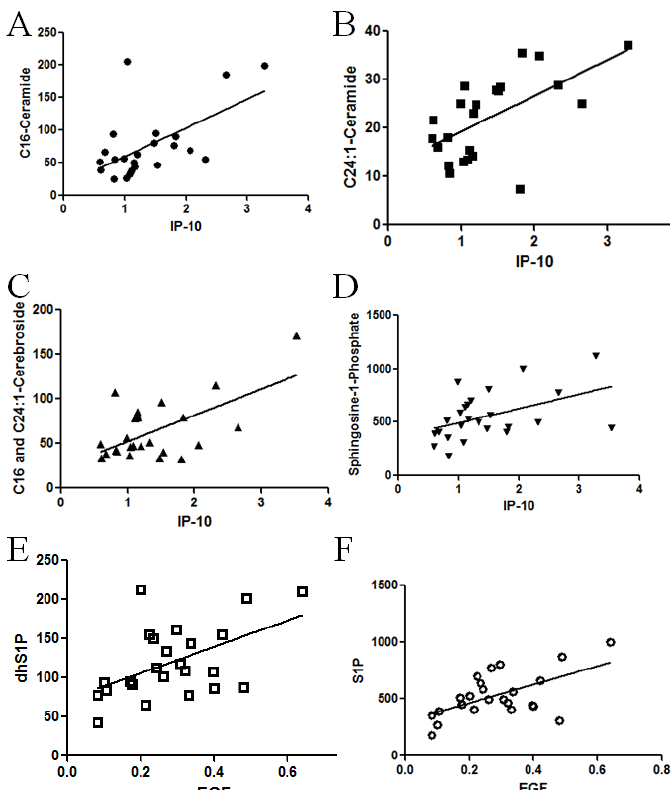
( A ) Tissue C16-ceramide and plasma IP-10 levels ( r = 0.583, p = 0.0035); and ( B ) tissue C24:1-ceramide and plasma IP-10 levels from tissue demonstrate a positive correlation ( r = 0.6012, p = 0.0024); ( C ) as did plasma C16:0 and C24:1 cerebroside mass ( r = 0.6174, p = 0.0013), with plasma IP10; and ( D ) plasma S1P with IP10 ( r = 0.4655, p = 0.019). Plasma EGF levels demonstrated positive correlated with both plasma; ( E ) S1P ( r =